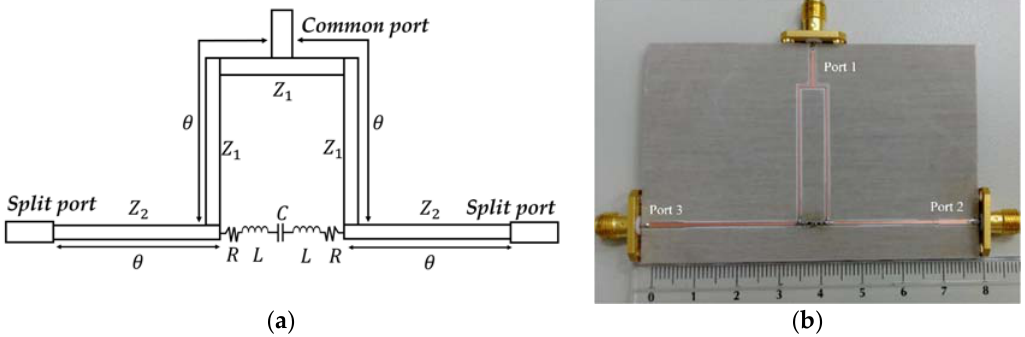
Figure 6. The simulated S ‐ parameters of various designs with different frequency ratios to show the applicability of the proposed approach.